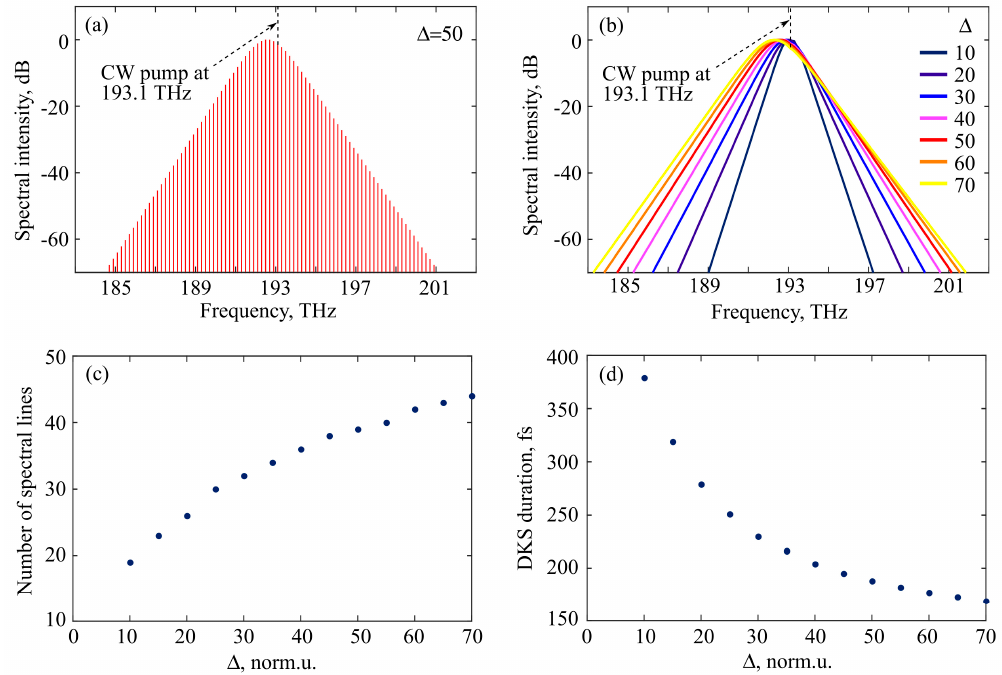
Figure 8. ( a ) Normalized intracavity spectral intensity of DKS for ∆ = 50. ( b ) Envelopes of normalized DKS spectra. ( c ) Number of spectral lines (harmonics) with spectral intensity higher than − 30 dB relative to the maximum as a function of normalized detuning. ( d ) FWHM DKS duration as a function of normalized detuning.